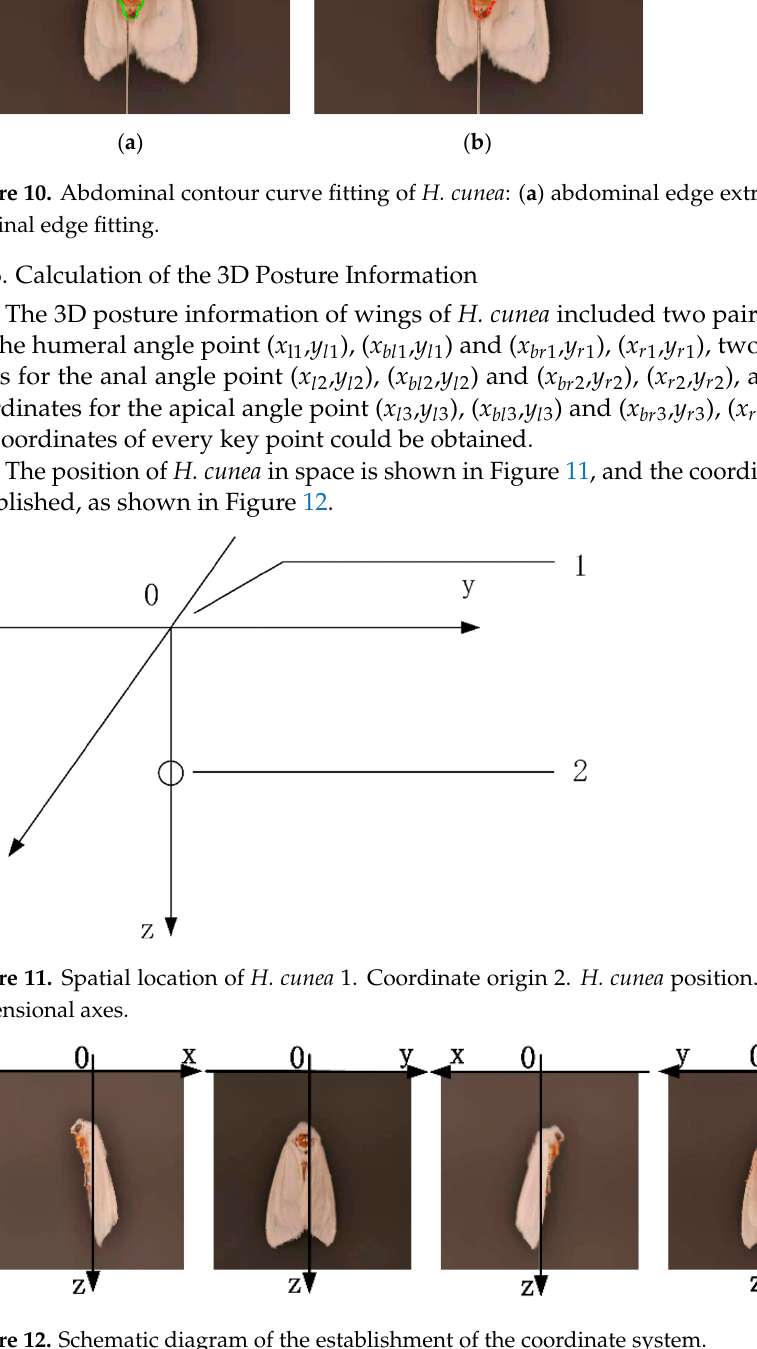
Figure 12. Schematic diagram of the establishment of the coordinate system. as